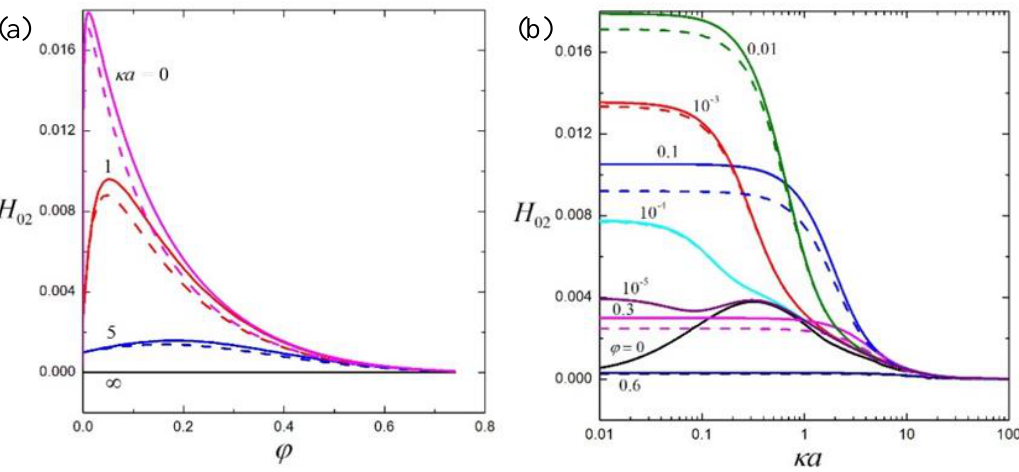
Figure 3. The chemiphoretic mobility coe ffi cient H 02 for a suspension of hard spheres versus the parameters ( a ) ϕ and ( b ) κ a . The solid and dashed curves represent the calculations for the Happel and Kuwabara models,